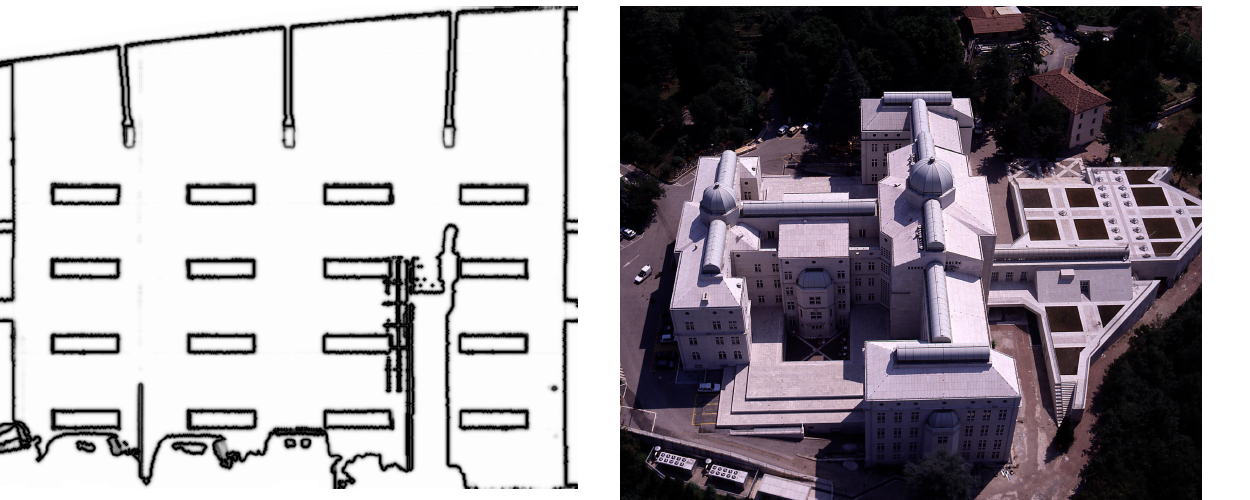
Figure 6: Plot of the auxiliary function s produced by the Mumford-Shah model applied to the facade of Figure (4)